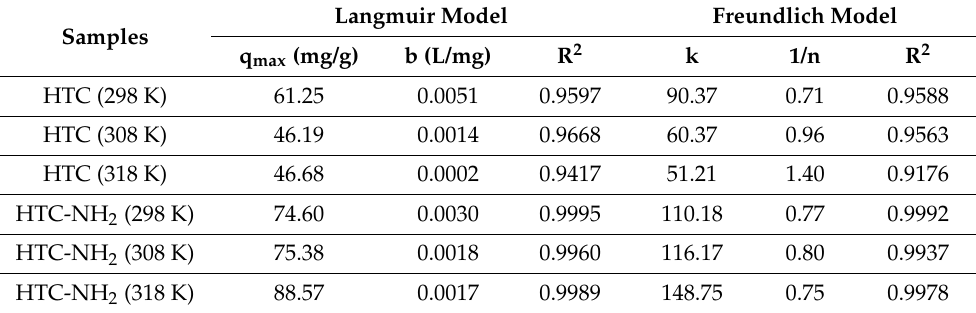
Table 3 . Isothermal adsorption parameters for Cr(VI) adsorption of samples . Table 3. Isothermal adsorption parameters for Cr(VI) adsorption of samples.